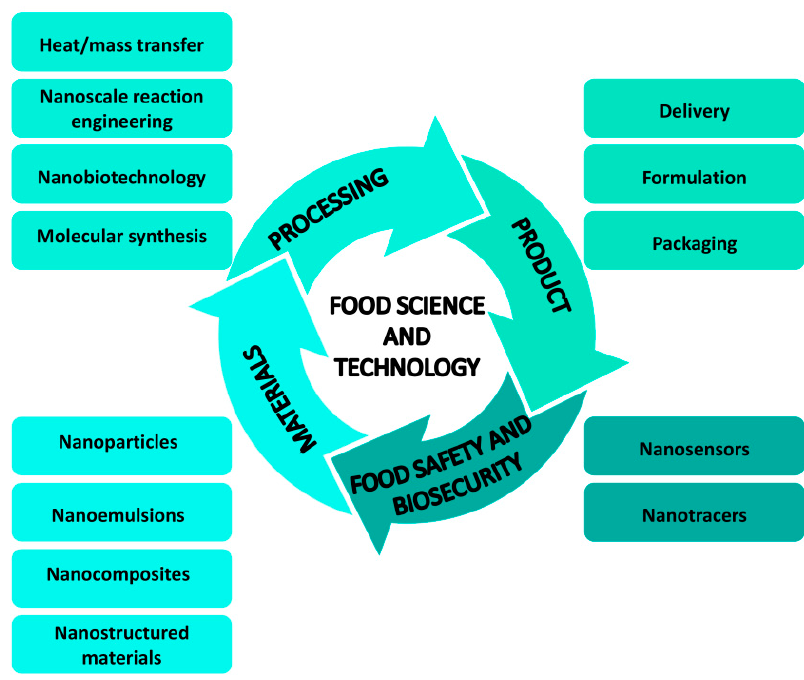
Figure 1. Schematic view of use of nanomaterials in food science and technology (adapted from Ramachandraiah et al. [13], with permission from publisher Asian-Australasian Journal of Animal Science, 2015).